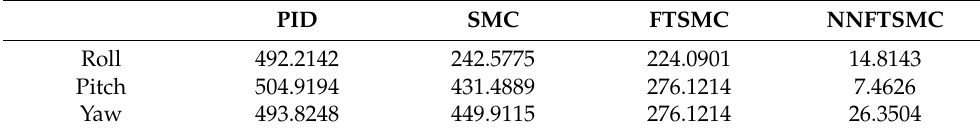
Table 2. The comparison of sine trajectory tracking results of IAE.